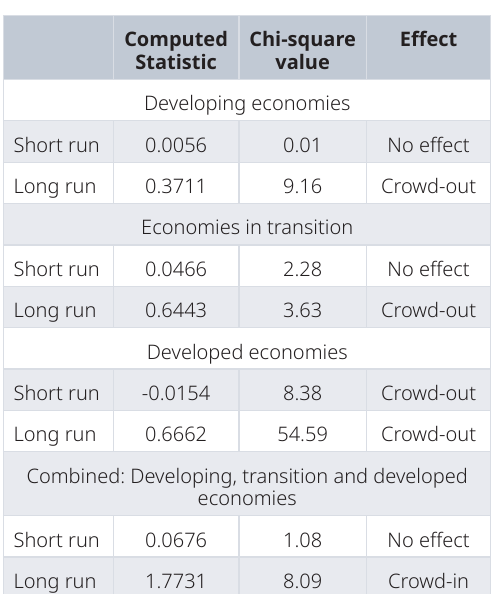
Table 8. Dynamic effects of FDI on DI for countries with different levels of